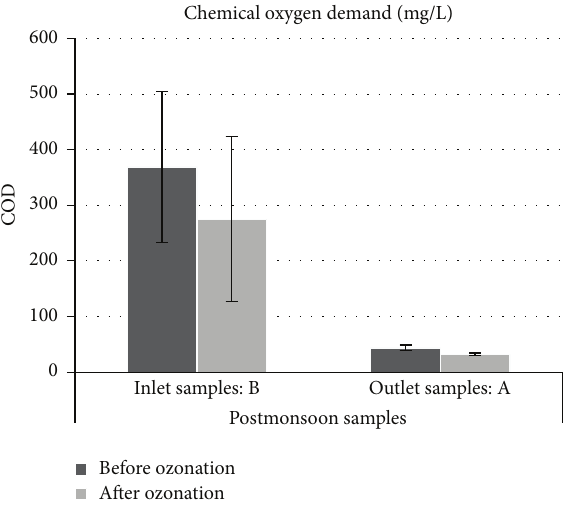
Figure 8: Chemical oxygen demand of inlet and outlet samples before and after treatment by ozone.